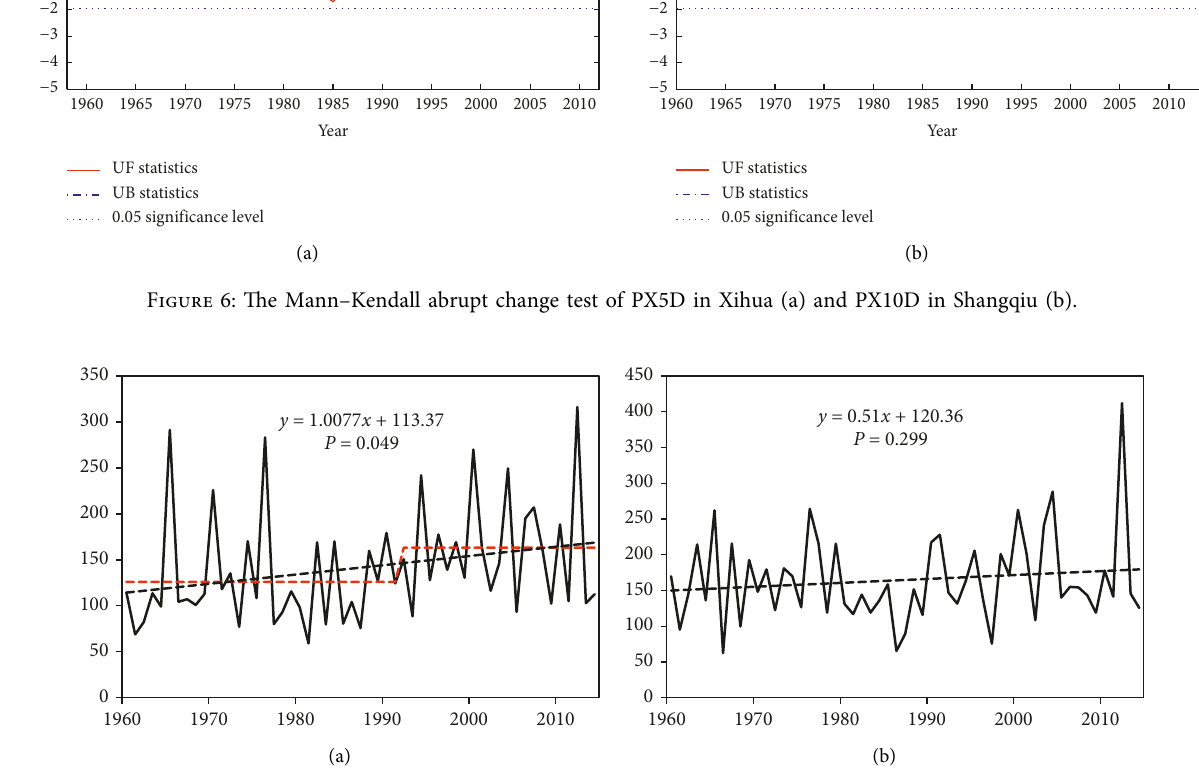
Figure 7: Time series of PX5D in Xihua (a) and PX10D in Shangqiu (b). The red dashed line shows the means of the subseries, and the black dashed lines show the linear trends.